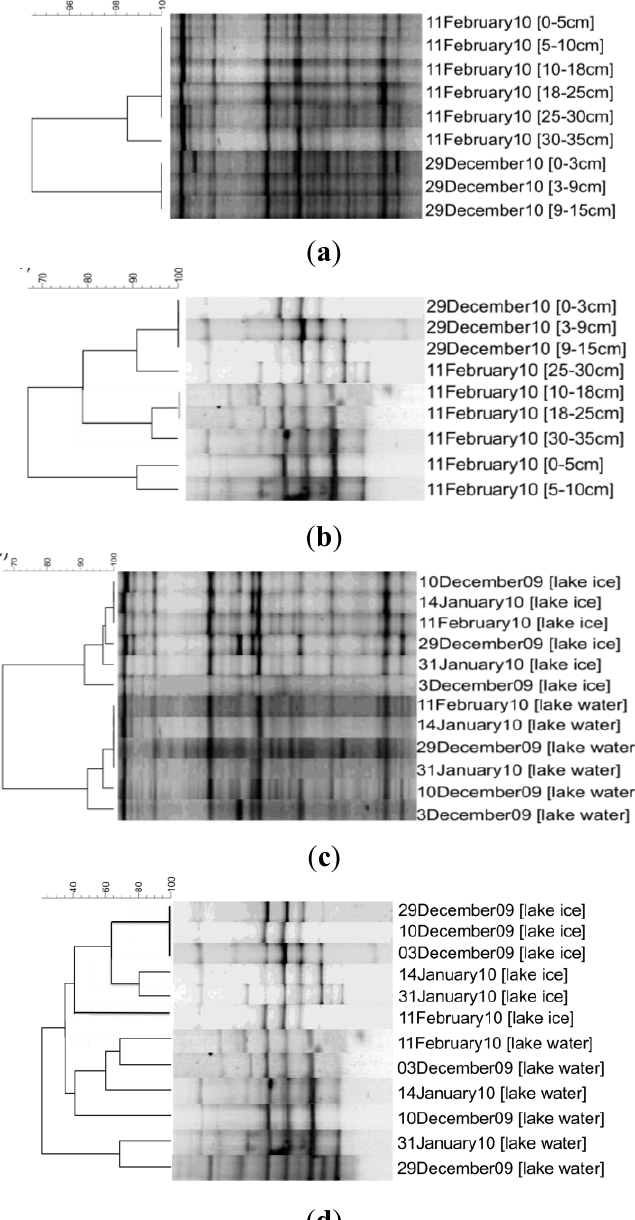
Figure 3. Cluster analysis of DGGE profiles from Miquelon Lake. Cladogram generated by Unweighted Pair Group Method with Arithmetic Mean (UPGMA) of Dice correlation coefficients (which reflect only band presence/absence, not band intensity). ( a ) Similarity of depth profile of Bacteria 16S rRNA genes in lake ice from two representative dates: 29 December 2009 and 11 February 2010. ( b ) Similarity of depth profile of Eukarya 18S rRNA genes in lake ice from two representative dates: 29 December 2009 and 11 February 2010. ( c ) Similarity of Bacteria 16S rRNA genes from homogenized ice cores or water samples from six representative dates: 3 December 2009, 10 December 2009, 29 December 2009, 14 January 2010, 31 January 2010, and 11 February 2010. ( d ) Similarity of Eukarya 18S rRNA genes from homogenized ice cores or water samples from six representative dates: 3 December 2009, 10 December 2009, 29 December 2009, 14 January 2010,